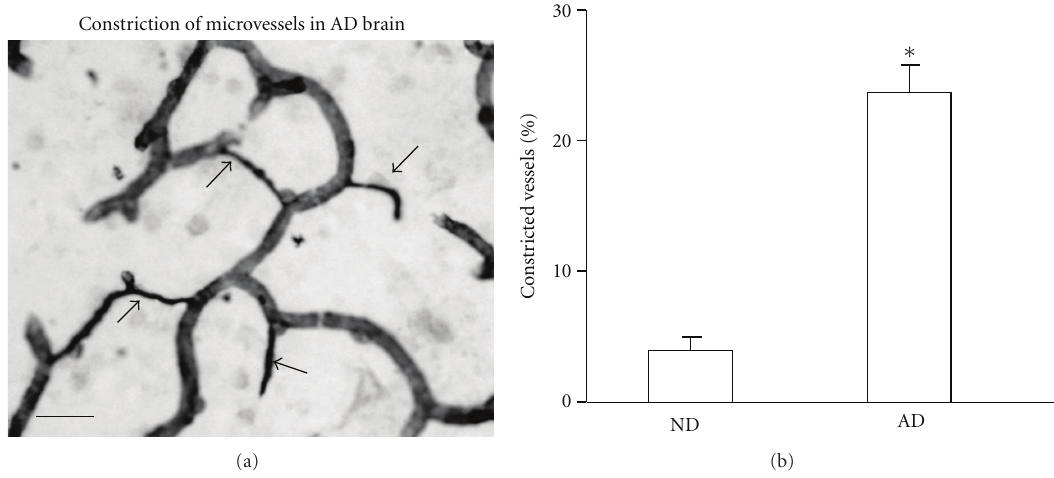
Figure 6: Constricted microvessels in AD brain tissue. (a) The arrows indicate constricted microvessels; scale bar is for 30 μ m. (b) Bar graph shows % of constricted, relative to total, microvessels for the di ff erent cases (ND, n = 9; AD; n = 9); ∗ P ≤ 0 . 05 for AD versus ND.